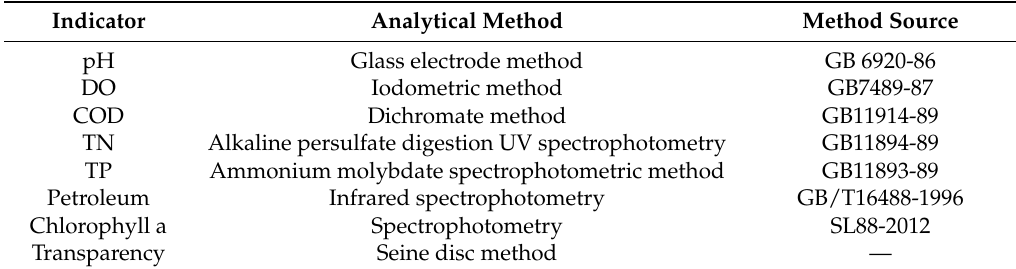
Table 2. The analytical method of each